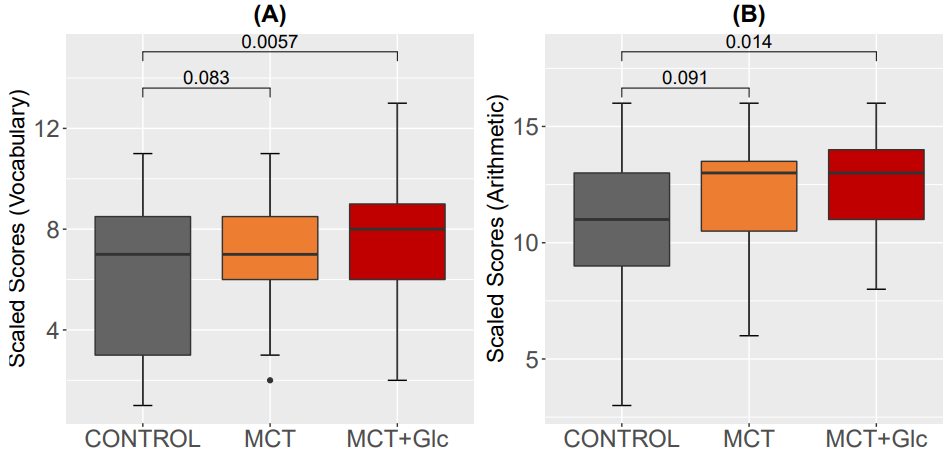
Figure 9. Results of subtests throughout the 5 h test day: ( A ) Vocabulary subtest; ( B ) Arithmetic subtest.